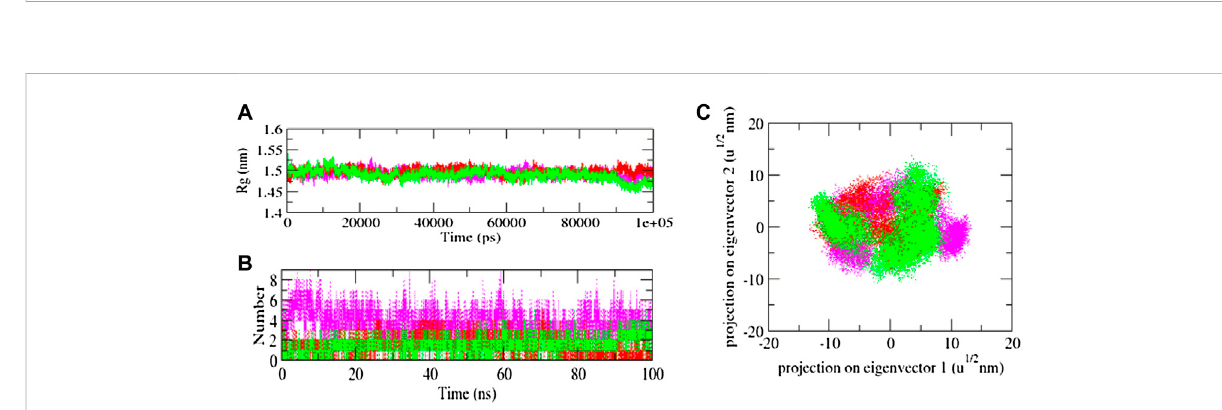
FIGURE 7 Radius of gyration plot of complexes (A) , Hydrogen bond interaction (B) , and 2D plot of projection (C) .